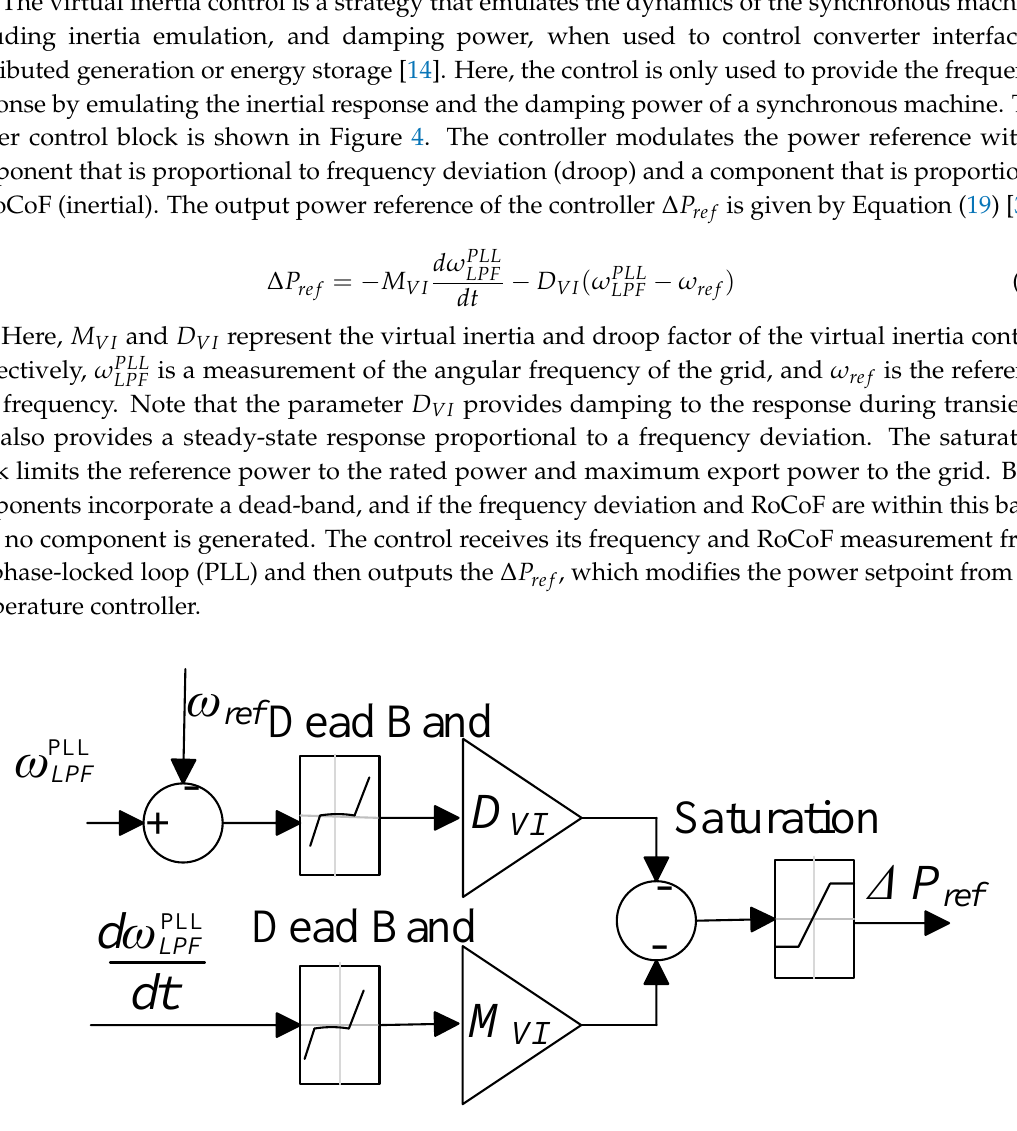
Figure 4. Block diagram of the power control of the virtual inertia